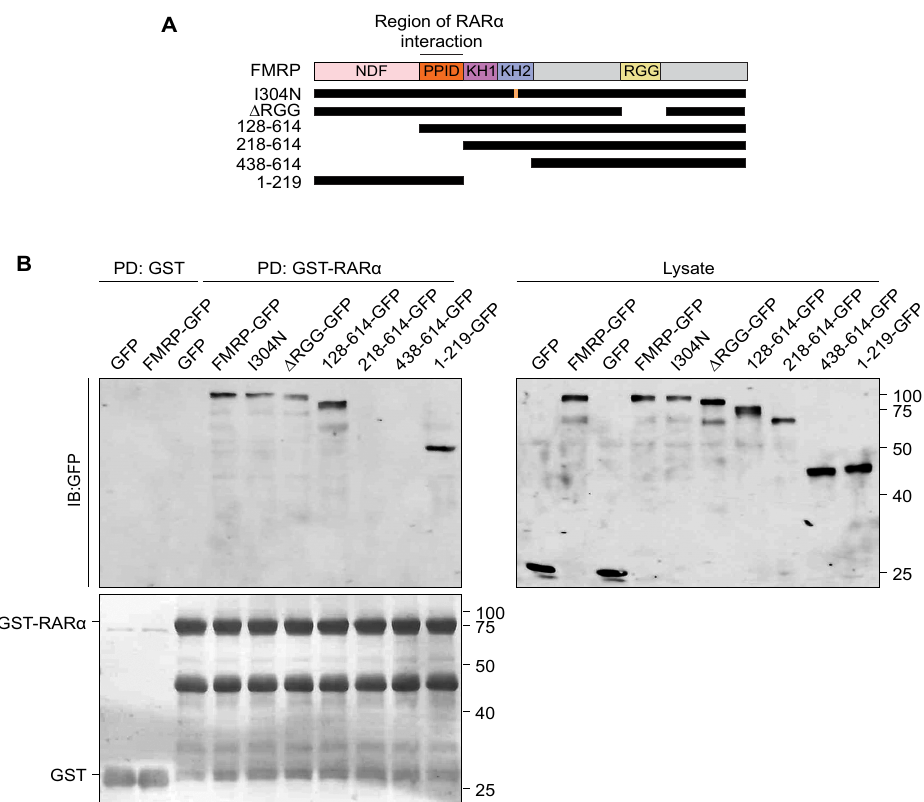
Figure 3. FMRP domains critical for the interaction with RAR α . ( A ) Schematics of FMRP domain organization and truncation/point mutations used to determine the RAR α binding site. All proteins have a C-terminal GFP tag. Numbering represents the position of amino acid in FMRP. ( B ) Pull-down of FMRP mutants from ( A ) expressed in Fmr1 KO MEFs with GST or GST-RAR α